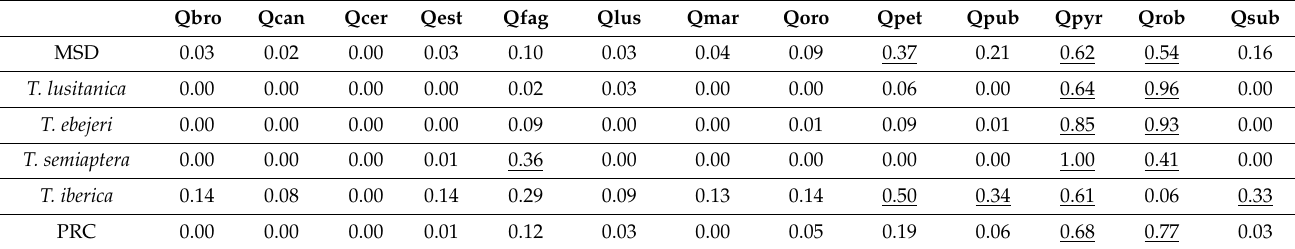
Table 4. Species distribution overlap: area intersected with Quercus species/total area target species. Oak species are: